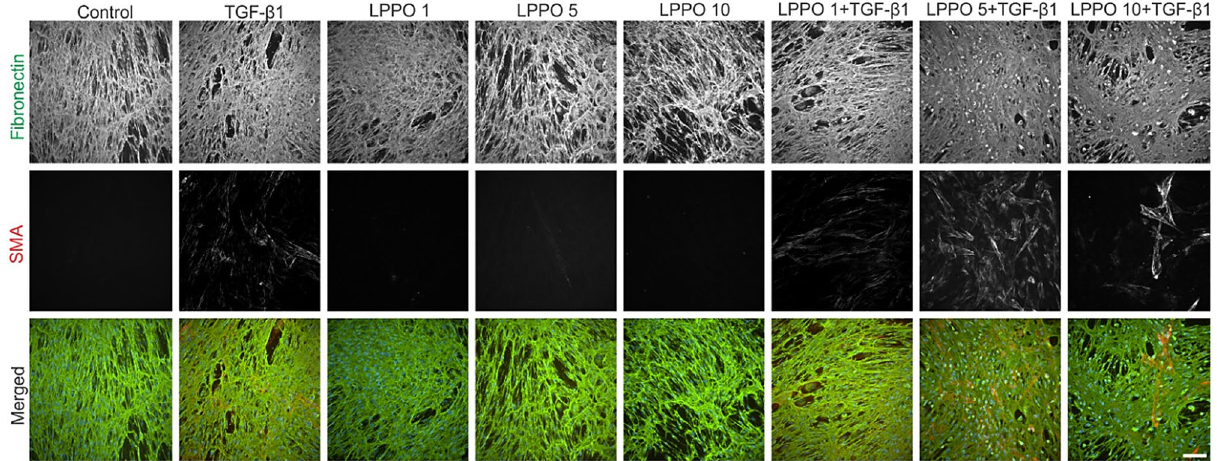
Figure 6. Immunofluorescent analysis of cytokeratins-8, 14 and 19 expression in human dermal fibroblasts cultivated with LPPO (1, 5, and 10 mg/L) in presence or absence of TGF-β1 (30 ng/mL) (scale bar = 100 µm).